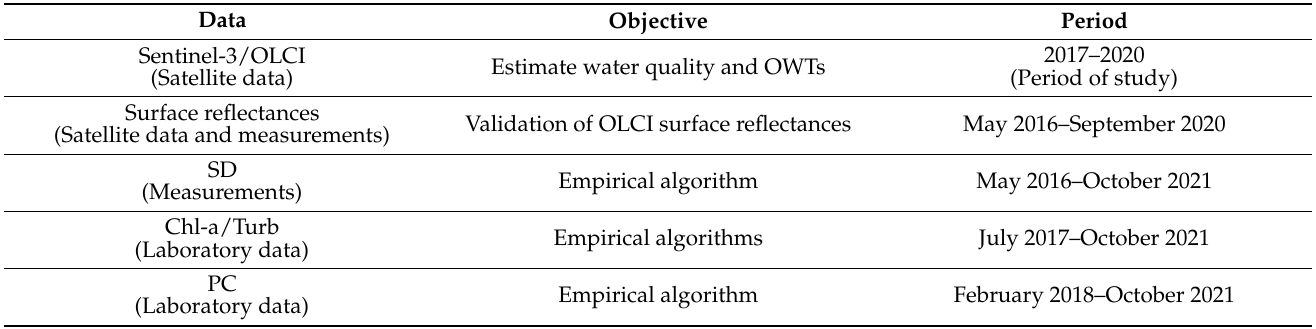
Table 1. Periods considered for each dataset